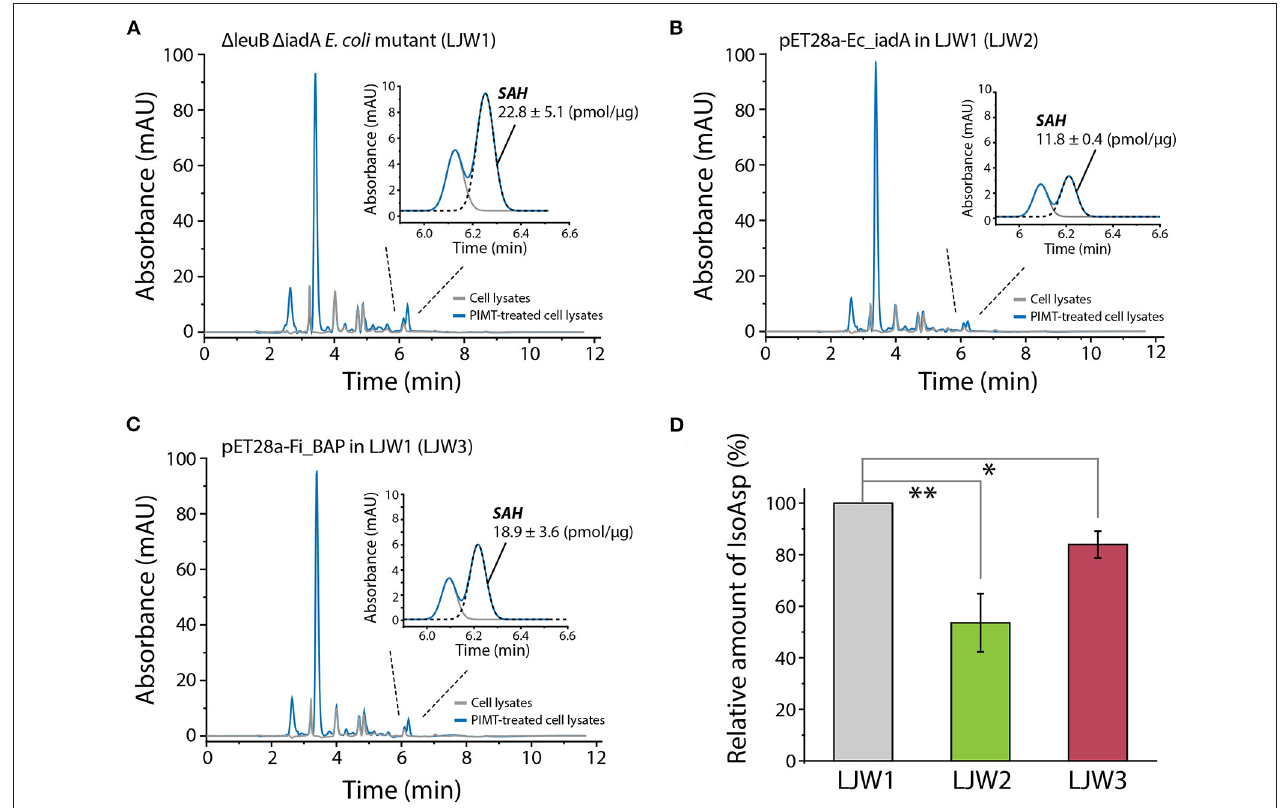
FIGURE 8 | RP-HPLC analysis of SAH for quantification of isoAsp residues in heat-shocked LJW1, LJW2, and LJW3 strains. (A–C) RP-HPLC analysis of SAH in LJW1, LJW2, and LJW3 strain and quantification of isoAsp by calculating the SAH peak area. (D) Relative amount of isoAsp in each heat- treated cell. Group differences were assessed using one-way analysis of variance (ANOVA), followed by LSD test [** p < 0.01 and * p < 0.05 vs. WT